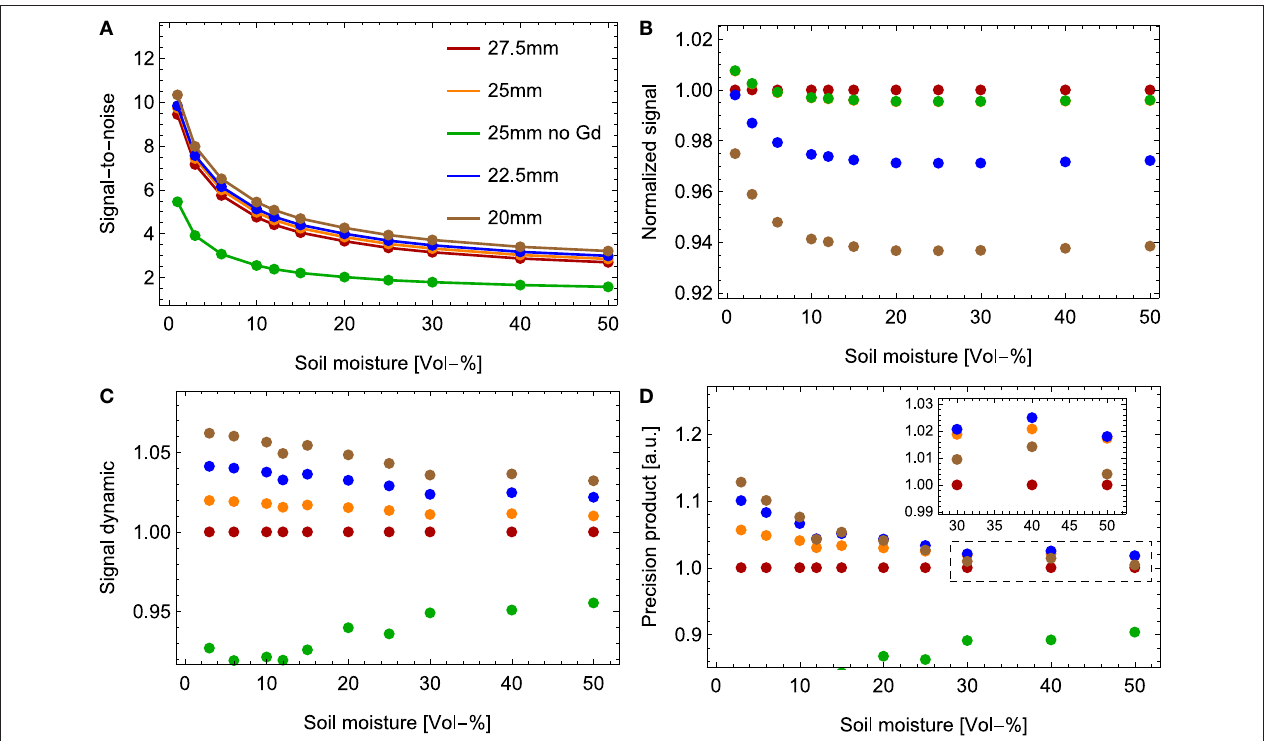
FIGURE 4 | Detector response to soil moisture dependent on the moderator thickness. All detector configurations feature a thermal shield except for “25mm no Gd.” (A) SNR according to the definition of section 3.1. (B) Signal count rates normalized to the detector setup with 27.5mm moderator thickness and a thermal shield. (C) Dynamical range or signal contrast, normalized like (B) . (D) Suggested optimization procedure, maximizing the product of statistical, and contrast precision according to Equation